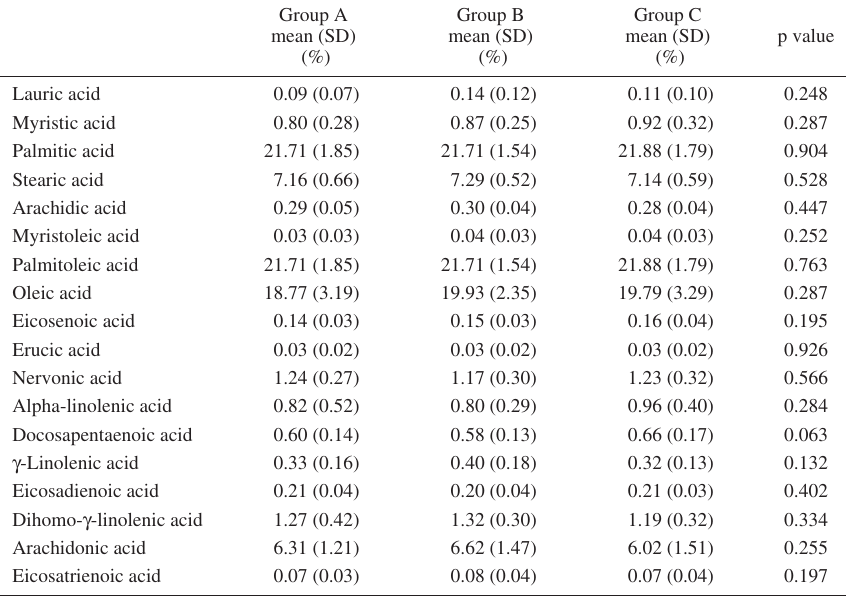
Table 3. Percentage of fatty acids with no significant differences in each age